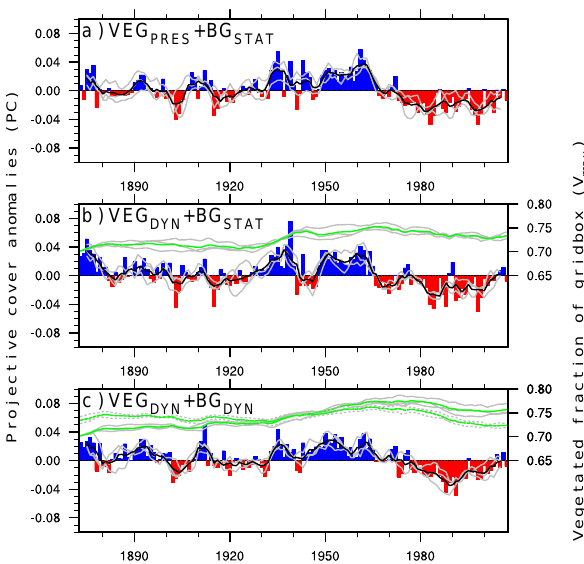
Fig. 7. Projective cover anomalies with regard to mean pro- jective cover for the years 1901–2006 in the Sahel for the (a) static (VEG PRES + BG STAT ) simulations, (b) dynamic vegeta- tion (VEG DYN + BG STAT ) simulations, and (c) dynamic vegetation and albedo (VEG DYN + BG DYN ) simulations. Bars show annual values of the ensemble mean. Lines across the bars show 5yr run- ning averages for the individual ensemble members (grey) and the ensemble mean (black). Lines above the bars show annual mean values of V max (right axis) for the individual ensemble members (grey) and for the ensemble mean (green). The dashed lines show the detrended series for the VEG DYN + BG DYN simulations.